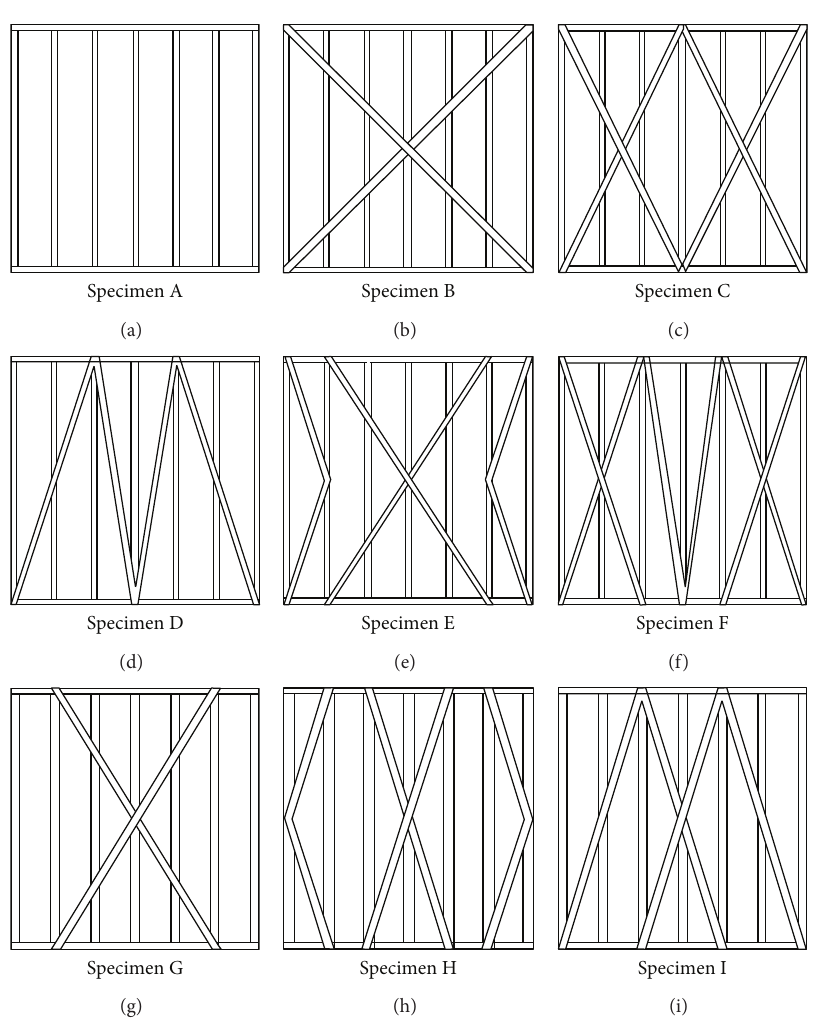
Figure 2: General configuration of